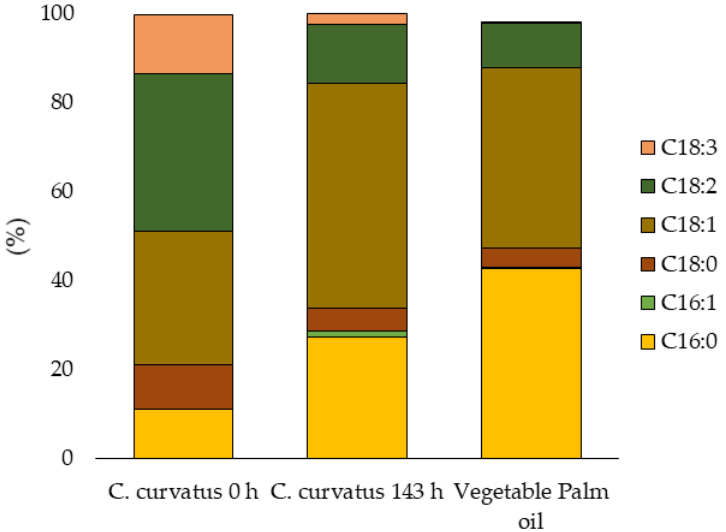
Figure 3. Comparison between the fatty acid profile of the lipids produced by C. curvatus at 0 h and 143 h, and the profile resulting from vegetable palm oil. Data source for vegetable palm oil: Demirbas [37] .